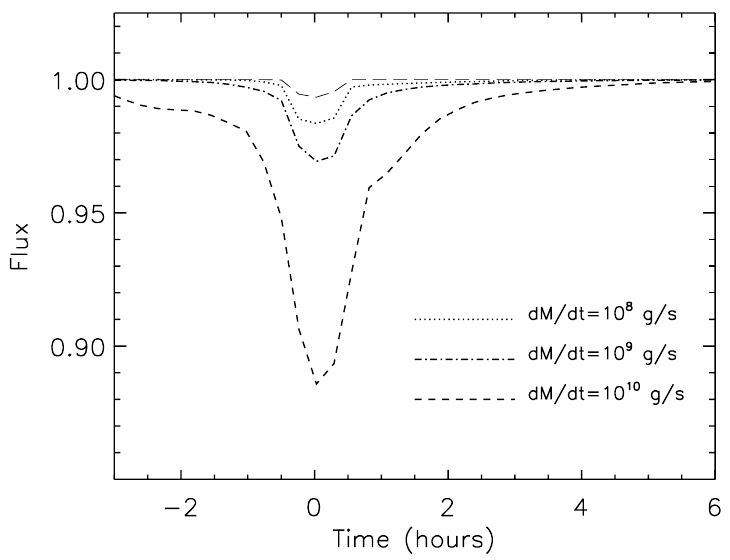
Figure 3: Predicted Ly α transit light curves for the hot neptune GJ 436b, assuming different possible values of the mass loss rate. From Ehrenreich, Lecavelier des Etangs & Delfosse